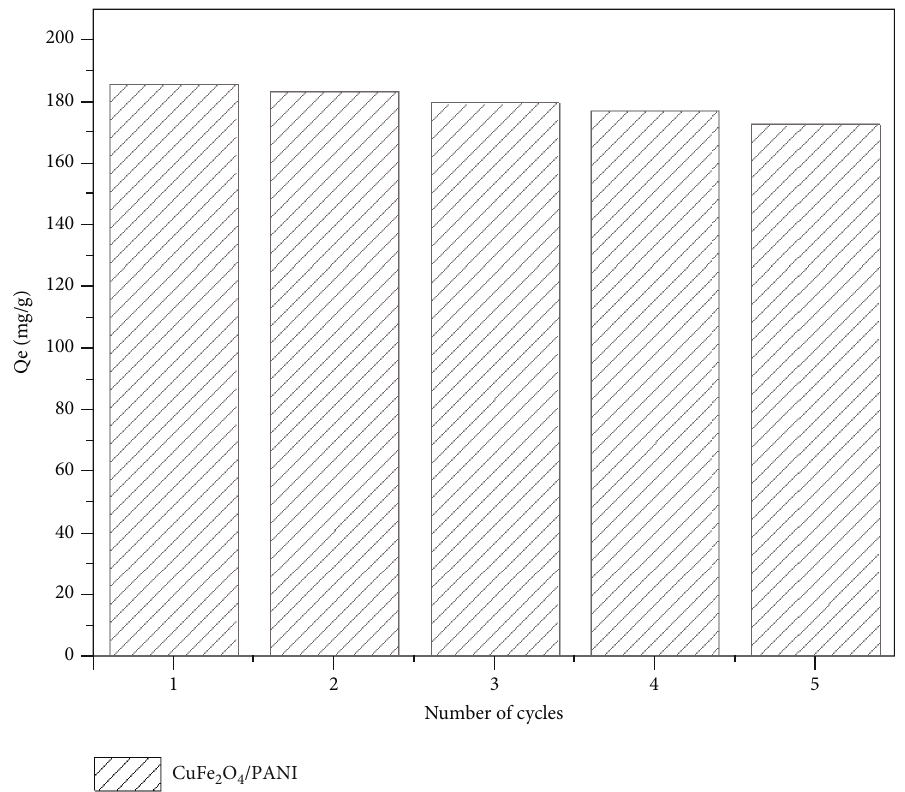
Figure 10: U (VI) adsorption e ffi ciency on recycled CuFe